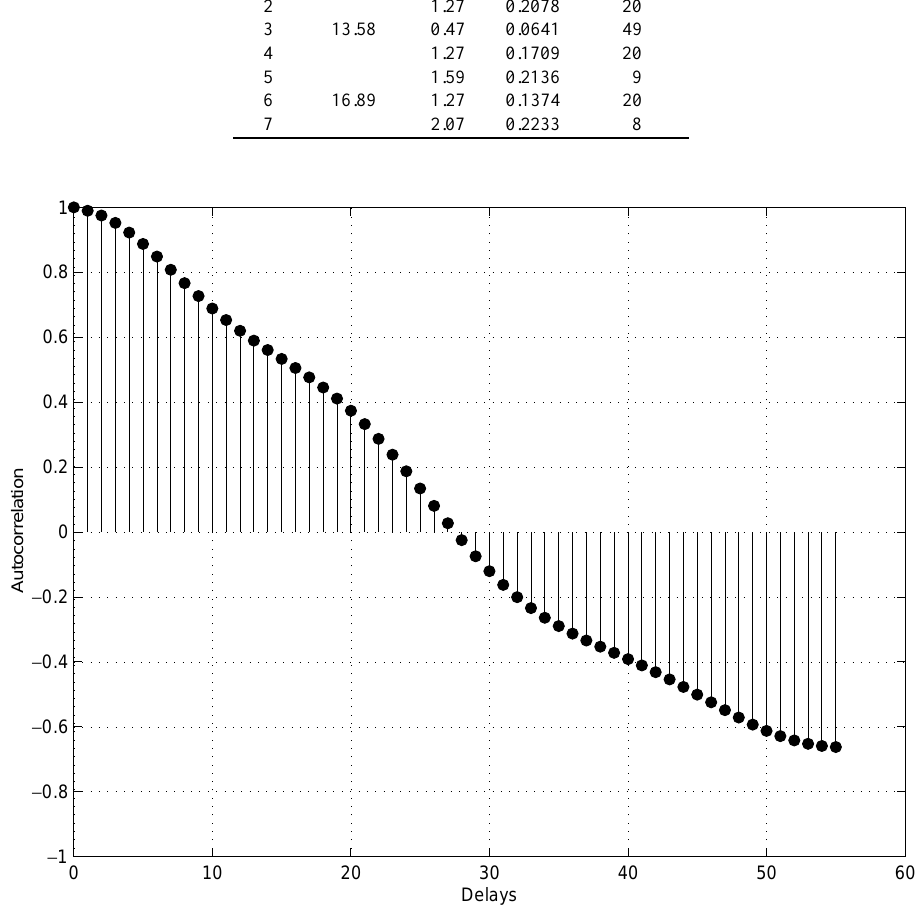
Fig. 3. Autocorrelation function and the time delay ( T )